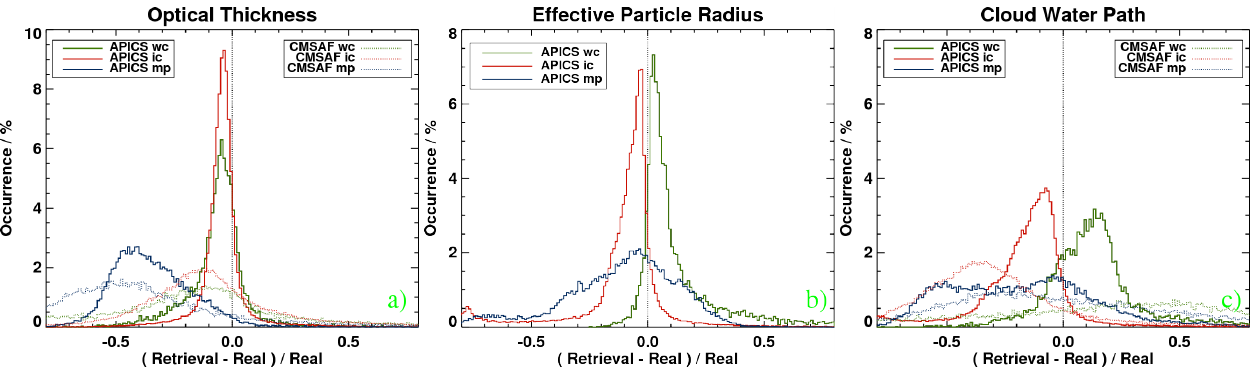
Fig. 11. Histograms of relative differences between retrieved and real cloud optical thickness a ), cloud effective radius b ) and cloud water path c ) for water (green), ice (red) and multi-phase (blue) clouds. Solid lines denote APICS retrieval results, dotted lines CMSAF retrieval results.